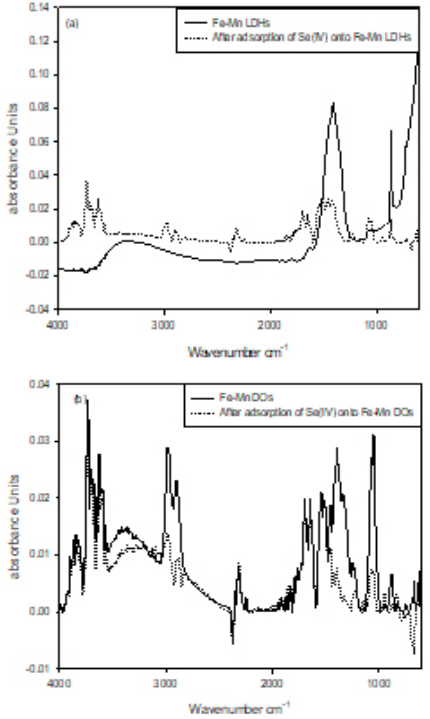
Fig. 3. FTIR spectra of after adsorption of Se(IV) by Fe-Mn LDHs and Fe-Mn